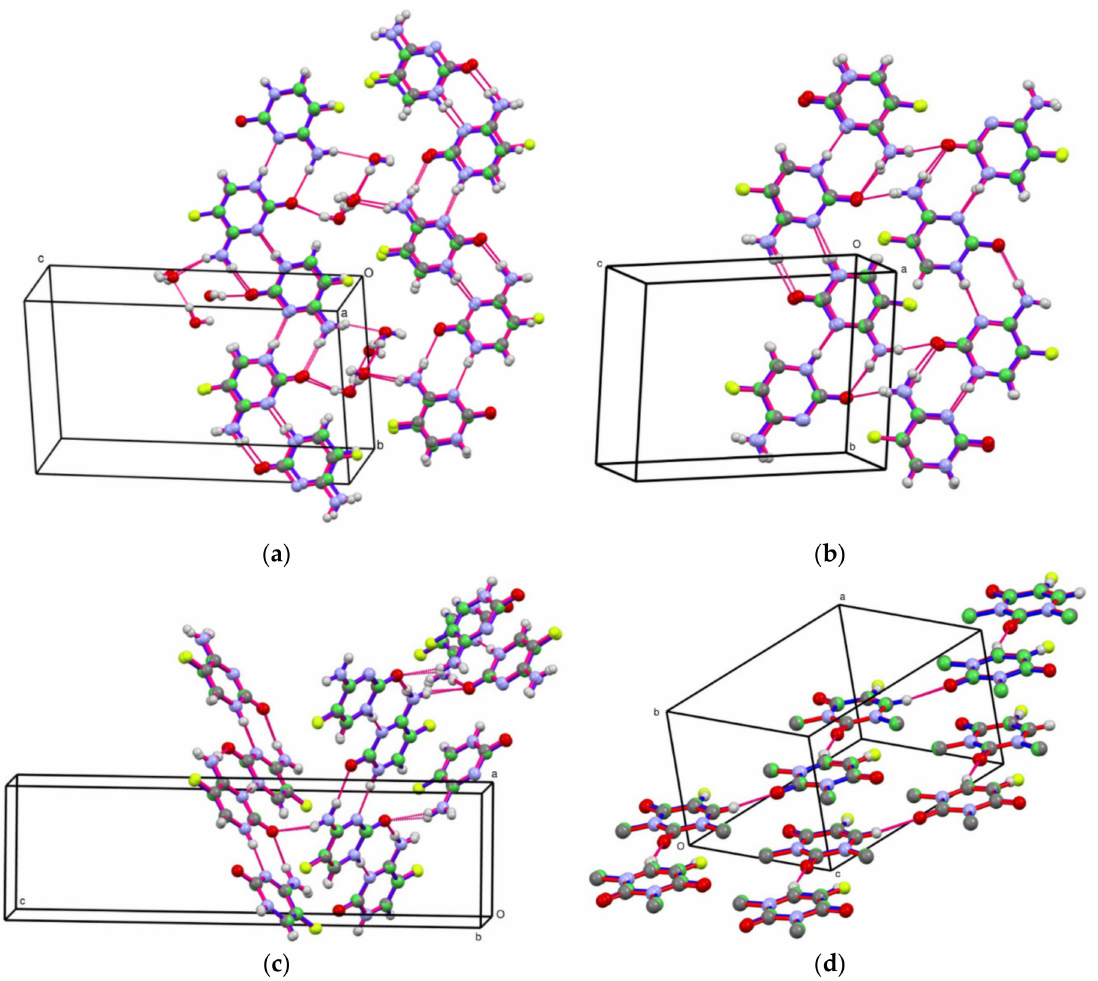
Figure 1. Overlay of part of the crystal structure showing crystal packing similarity for: ( a ) BIRMEU02 and SAVKIM, viewed approximately down a . Bonds of molecules of BIRMEU02 have been colored red, and bonds of molecules of SAVKIM are blue. ( b ) MEBQEQ and ADAJAT, viewed approximately down a . Bonds of molecules of MEBQEQ have been colored red, and bonds of molecules of ADAJAT are blue. ( c ) MEBQEQ01 and ADAJAT01, viewed approximately down b . Bonds of molecules of MEBQEQ01 have been colored red, and bonds of molecules of ADAJAT01 are blue. ( d ) KAMSAS01 and OKATEB, viewed approximately down b . Bonds of molecules of KAMSAS01 have been colored red, and bonds of molecules of OKATEB are blue. For the sake of simplicity, overlay of part of the crystal structure of the pairs DMURAC01 / OKATEB and KAMSAS01 / DMRAC01, similar to that of the pair KAMSAS01 / OKATEB, has been omitted. All atoms are shown as small spheres of arbitrary radii. Hydrogen bonding is indicated by red dashed